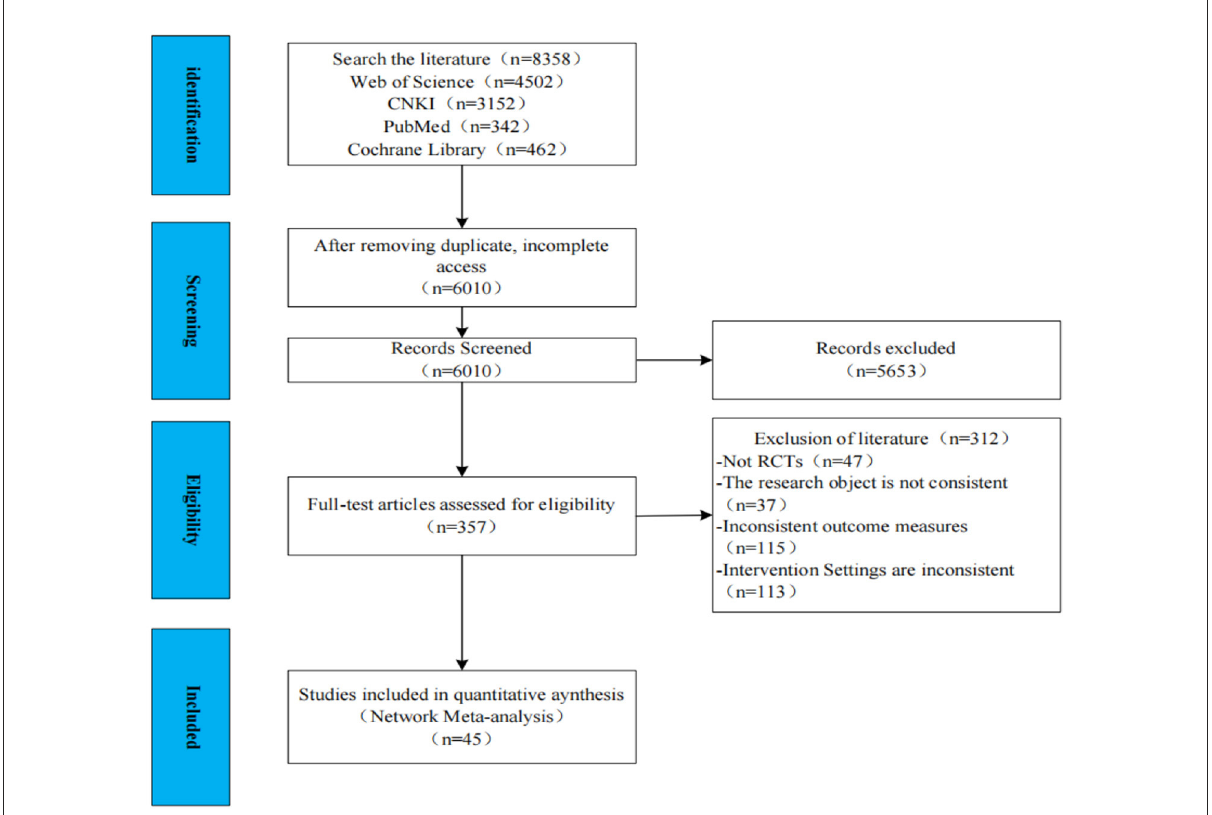
FIGURE1 Flow chart of literature